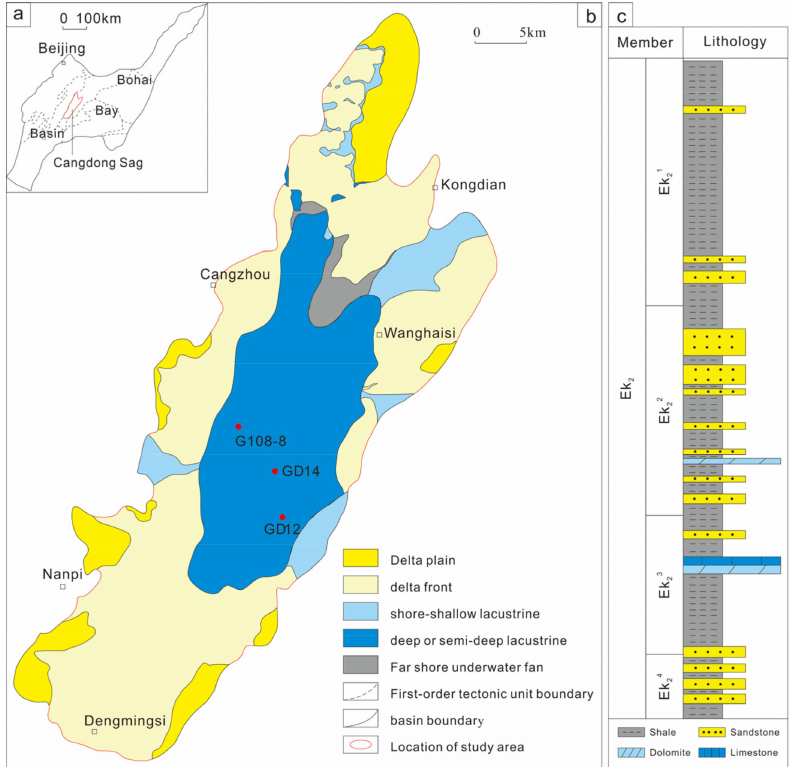
Figure 1. Areal distribution of sedimentary facies and stratigraphy development of the study area (modified after [27]). ( a ) The location of the Cangdong Sag in the Bohai Bay Basin; ( b ) areal distribution map of sedimentary facies of the second Member of Kongdian Formation; ( c ) stratigraphy development of the second Member of Kongdian